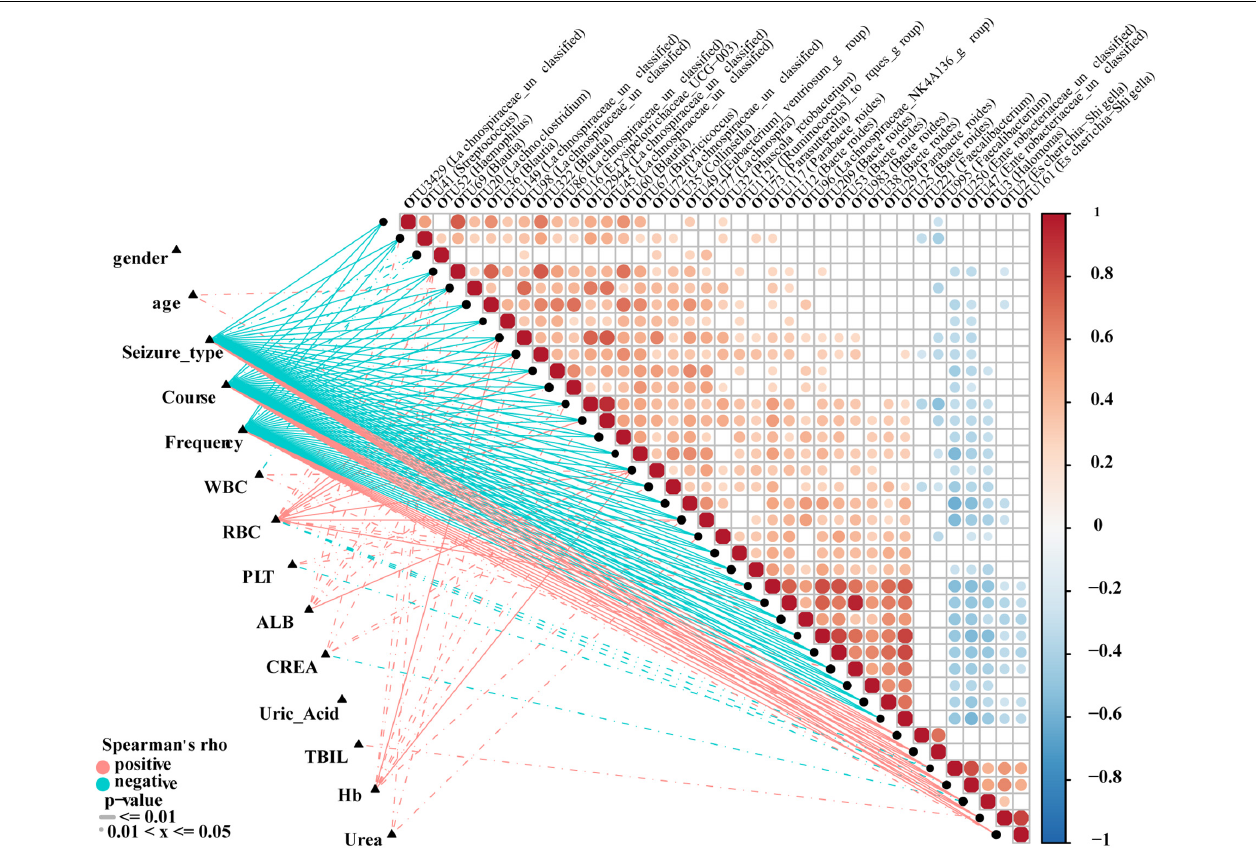
FIGURE 8 | Correlation analysis of differential OTUs and clinical characteristics of epilepsy patients. Heat map showing partial Spearman’s correlation coefficients among 38 OTUs and clinical indices. Positive values indicate positive correlations. Negative values (blue) indicate inverse correlations. Solid lines represent P ≤ 0.01. Dotted lines represent 0.01 < P ≤ 0.05. The intensity of shading in circles is proportional to the magnitude of the association. Correlation direction was determined by Spearman’s method. Eps, patients with epilepsy; WBC, white blood cells; RBC, red blood cells; Hb, hemoglobin; PLT, platelets; ALB, albumin; UREA, urea; CERA, creatinine; UA, uric acid; TBIL, total